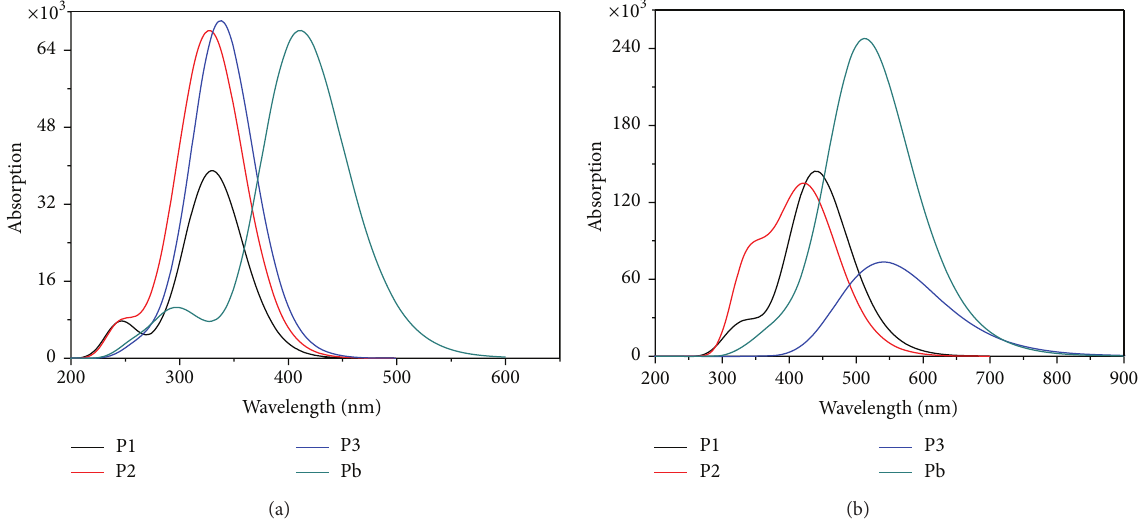
Figure 5: Absorption spectra of P1, P2, P3, and PBDT-BTA (Pb) for (a) 𝑛 = 1 and (b) 𝑛 = 3 .